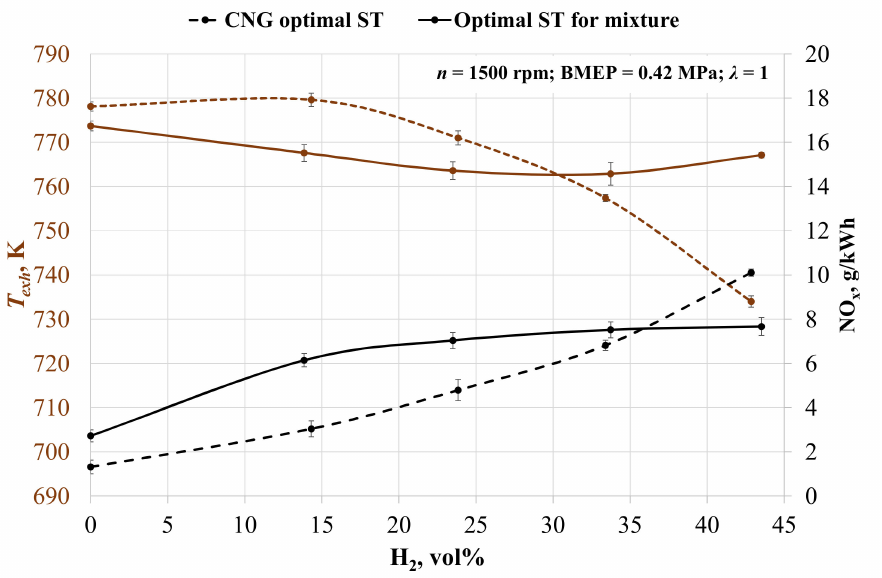
Figure 4. Change in exhaust gas temperature (T exh ) and specific emission of nitrogen oxides (NO x ) depending on the volumetric fraction of hydrogen and spark